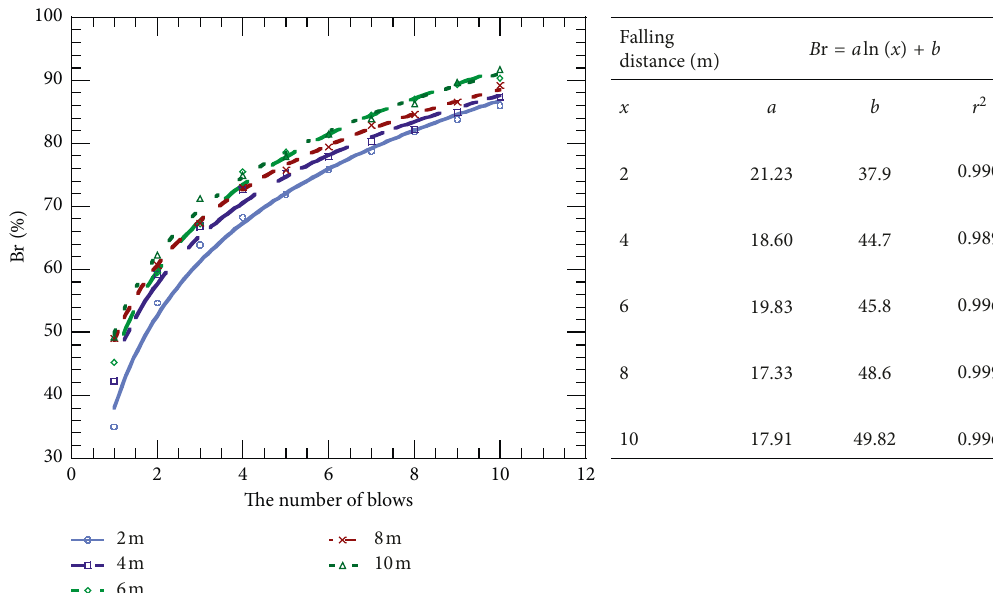
Figure 10: The relationship between the relative breakage and the number of tamping blows.